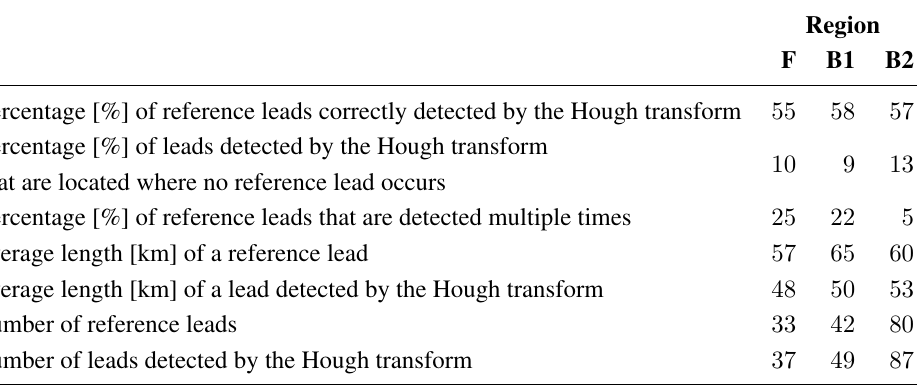
Table 1. Summary of a comparison of reference leads with leads detected by the